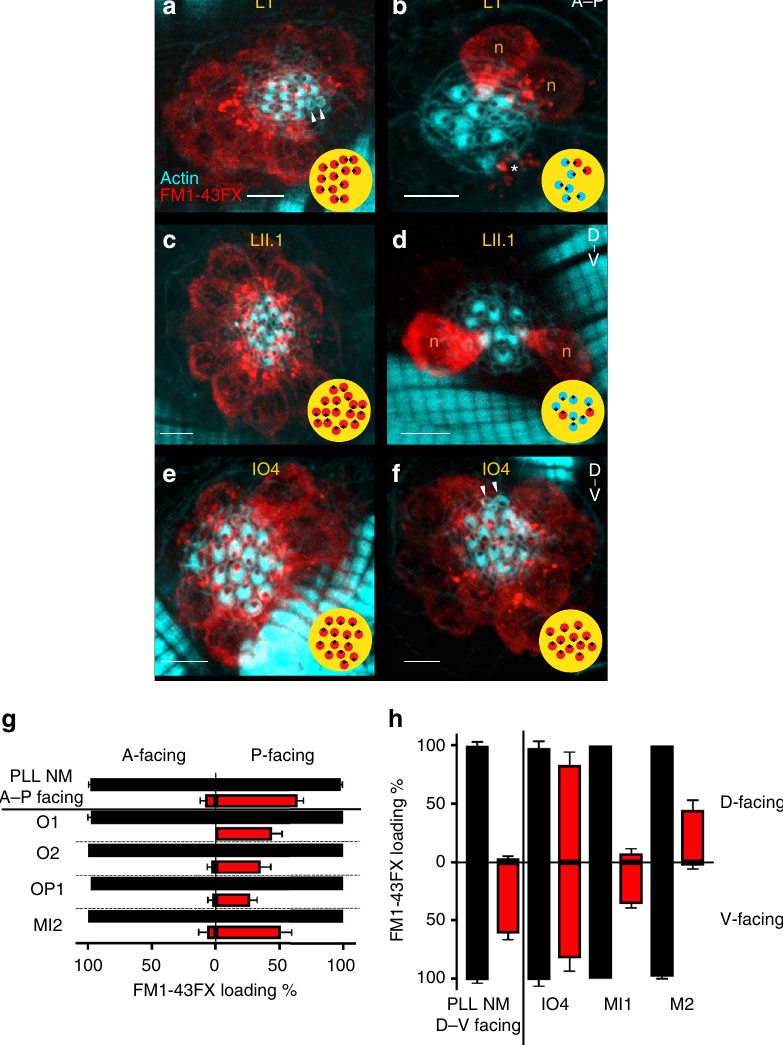
Fig. 5 Hair cell PCP and neuromast position govern dependence of mechanotransduction channel function on Tmc2b. a – f Confocal images of hair cells from L1, LII.1, and IO4 neuromasts of tmc2b + / − or tmc2b − / − animals. FM1-43FX (red) uptake reveals functional channels, and phalloidin (cyan) shows hair bundle polarity. Qualitative maps (yellow) of micrographs from tmc2b − / − mutants show that subpopulations of posterior- and ventral-facing hair bundles